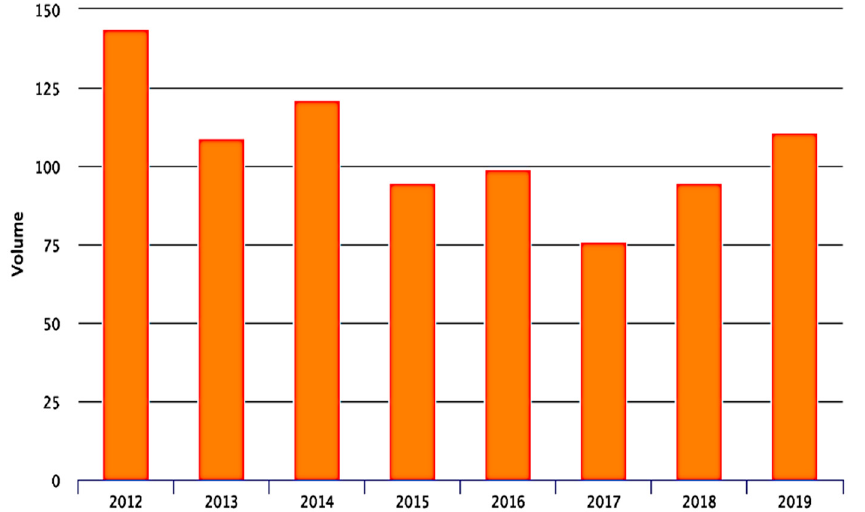
Figure 3. Number of acute ischemic stroke admitted in the spoke hospital of Santa Maria della Stella Hospital in Orvieto from 2012 to 2019.